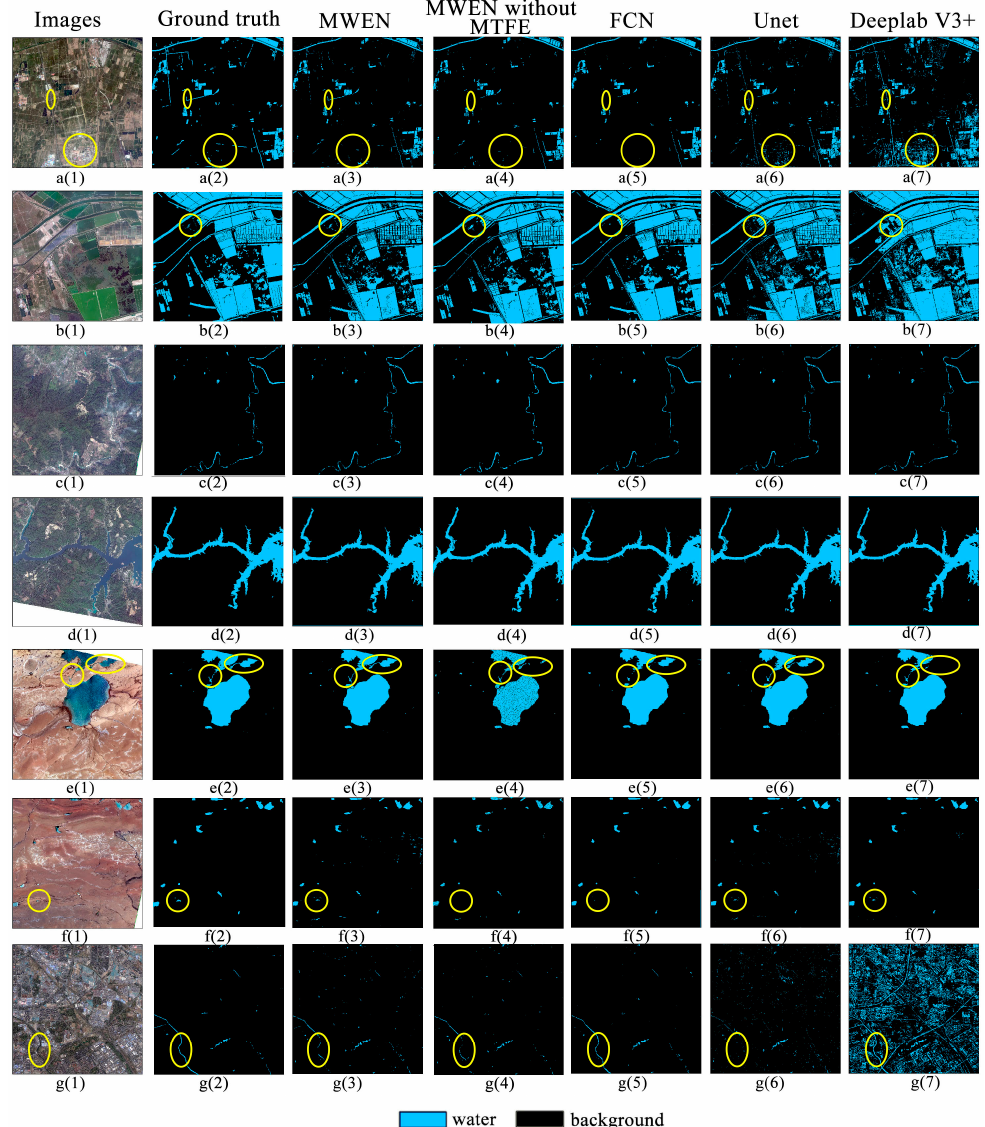
Figure 8. The results classified by the four CNNs on the test dataset. (a1–g1) are the original images, (a2-g2), (a3-g3), (a4–g4), (a5–g5), (a6–g6), (a7–g7) are the water body information extracted by artificial interpretation, MWEN, MWEN “without MTFE”, FCN, Unet, Deeplab V3+, respectively. The areas in yellow circles are the areas water bodies greatly differ. Blue parts of the pictures represent the extracted water bodies and black parts of the pictures represent the background.